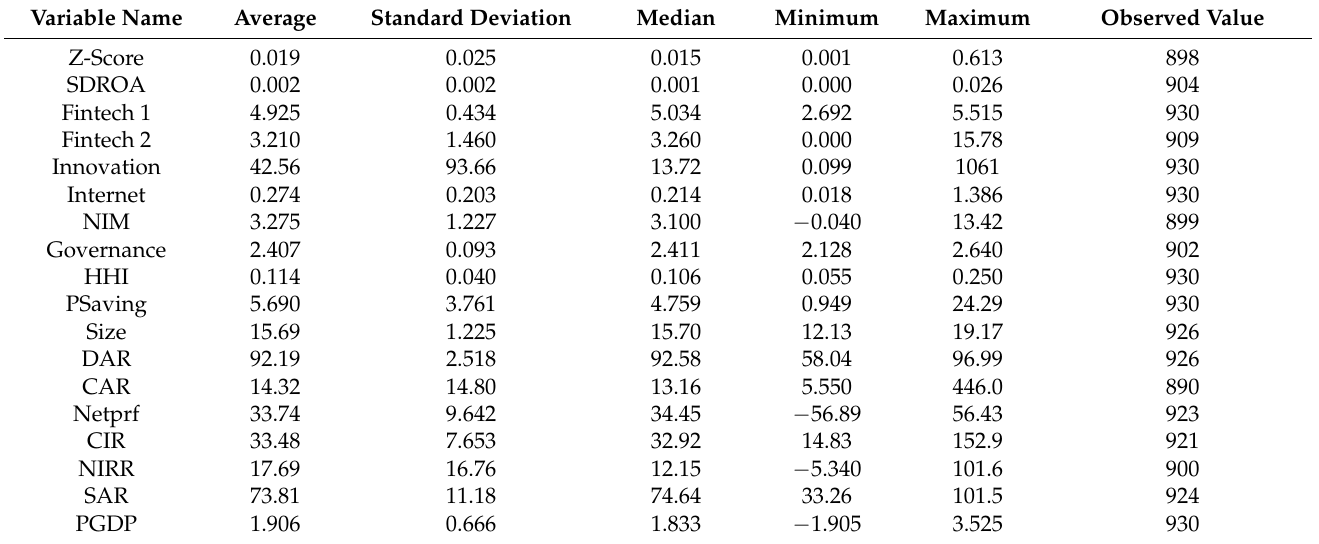
Table 2. Descriptive statistics of variables.